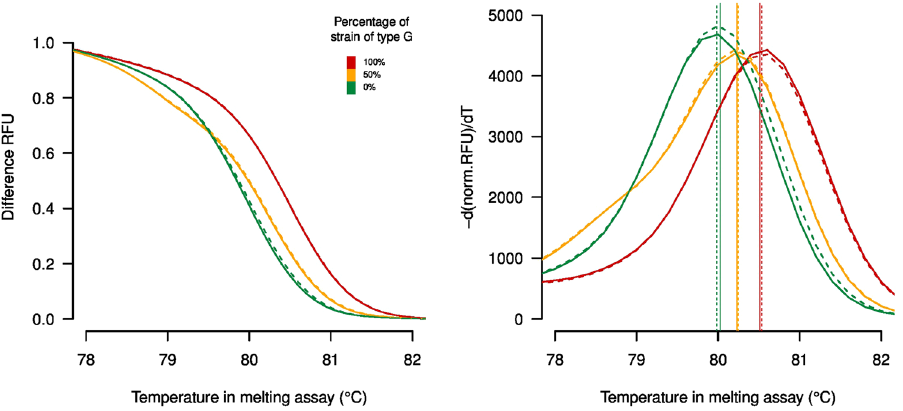
Figure 1. High-resolution DNA melting curve analysis results for a 97-bp amplicon containing one SNP in trpB gene for Flavobacterium columnare . (Right) Normalized melting curves, (Left) derivative plots. The melting curves depict pure genotype A, pure genotype G, and 50/50 ratio of both genotypes. Solid and dashed lines represent replicate